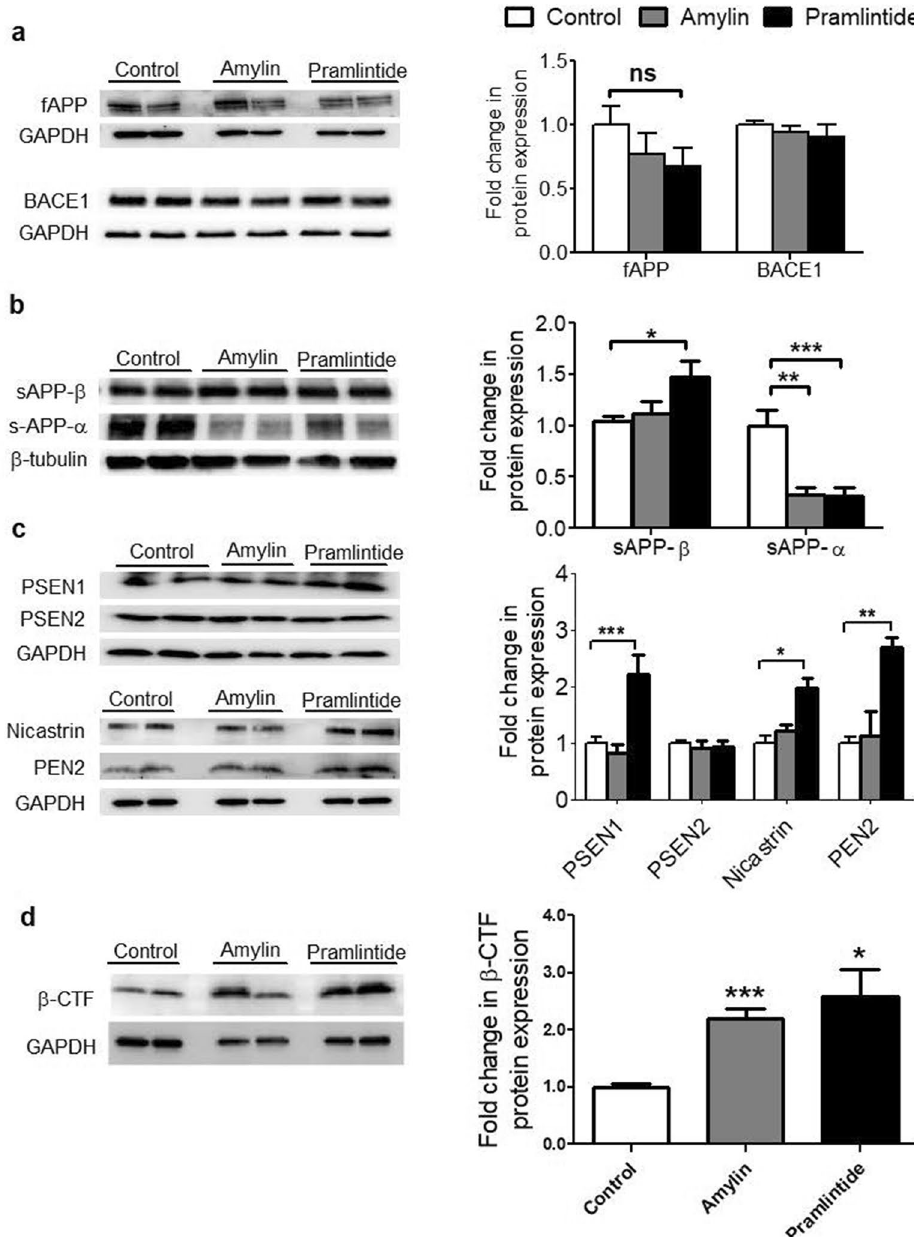
Figure 1. Effect of amylin and pramlintide on APP processing in total brain homogenate. ( a ) Representative Western blot and densitometry analysis of full-length APP (fAPP) and BACE1 demonstrated amylin and pramlintide did not alter full-length APP (fAPP) and BACE1 in mice brain homogenates. The fAPP and BACE1 levels were normalized to GAPDH level. ( b ) Representative Western blot and densitometry analysis of sAPP-β and sAPP-α in mice brains demonstrated pramlintide significantly increased sAPP-β compared to control, whereas reduction in the level of sAPP-α was observed after treatment with amylin and pramlintide. The levels of sAPP-β and sAPP-α were normalized to the level of β-tubulin. sAPP-β and sAPP-α were ran on different gels due to molecular weight similarity. ( c ) Representative Western blot and densitometry analysis of γ-secretase subunits in mice brains demonstrated pramlintide caused a significant increase in PEN2 subunit when compared to control and amylin; however, neither peptide influenced the other γ-secretase subunits PSEN1, PSEN2 and nicastrin. The level of γ-secretase subunits was normalized to level of GAPDH in each corresponding lane. PSEN1 and PSEN2 were ran on different gels due to molecular weight similarity. ( d ) Representative Western blot and densitometry analysis of β-CTF in mice brains demonstrated amylin and pramlintide caused a significant increase in β-CTF when compared to control. Data is presented as mean ± SEM, and the densitometry analysis is from n = 6 mice in each group. The western blot results are representative results from two different mice from each group. Data is presented as mean ± SEM and the statistical significance for all result was assessed by student t-test, with * p < 0.05, ** p < 0.01, *** p < 0.001 compared to control group; # p < 0.05 compared to pramlintide, and ns = not